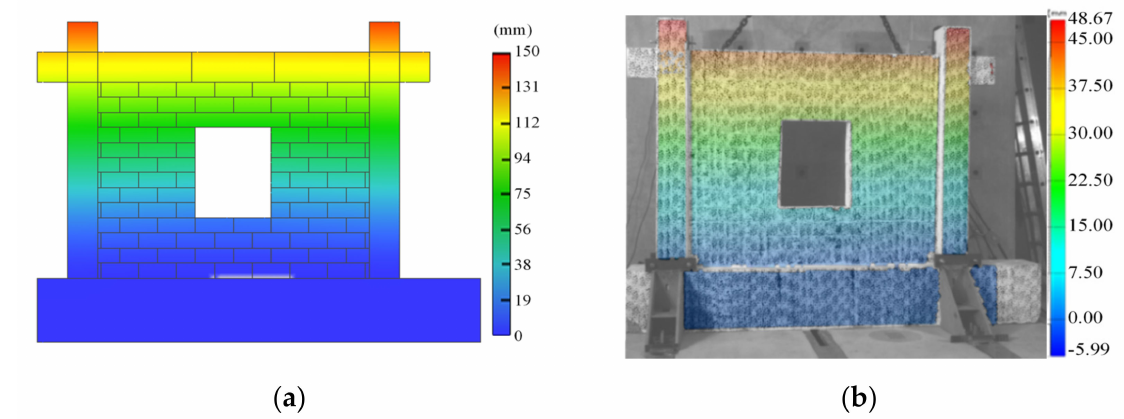
Figure 26. OoP displacement maps of CW model (others had nearly the same pattern). ( a ) Computational model (@ d r ∼ = 10%); ( b ) Experimental model (@ d r ∼ =